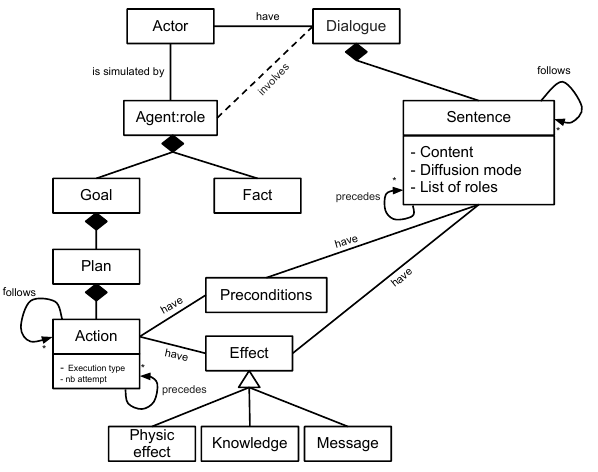
Figure 4. The SIMFOR Game Agent